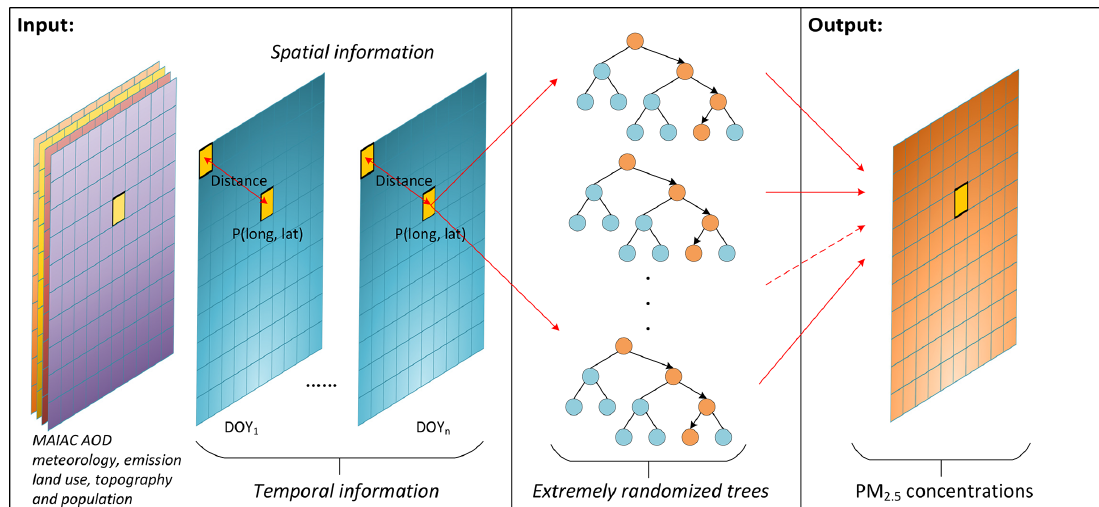
Figure 4. Schematic of the enhanced STET model developed in our study.